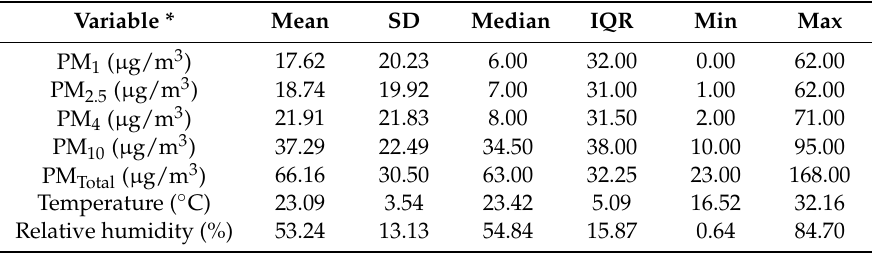
Table 2. Summary statistics for indoor PM concentration, temperature and relative humidity ( n =